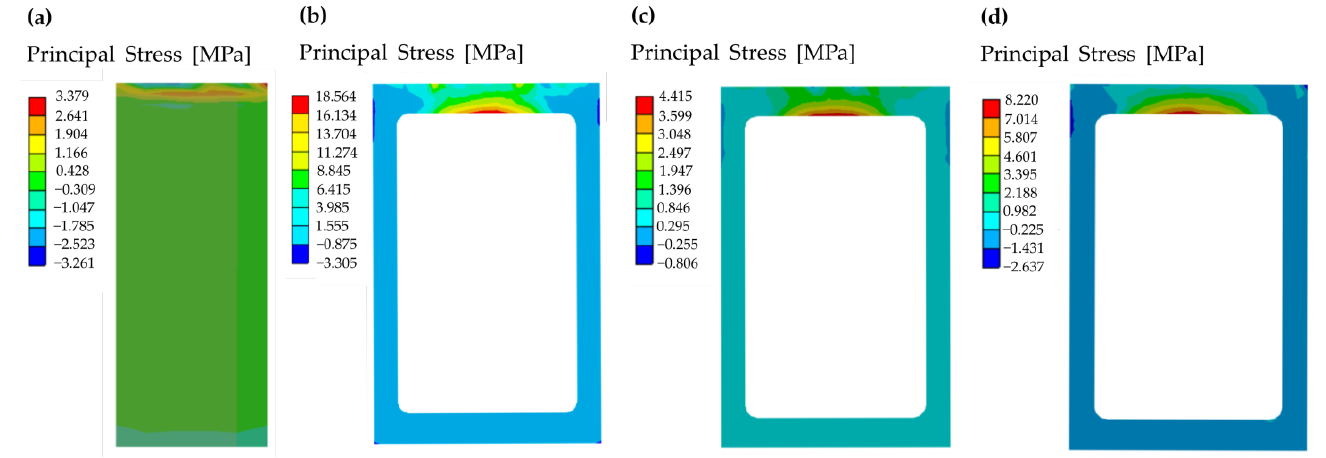
Figure 13. Distribution plot of the principal stresses of the core walls for the ( a ) HR-Liner; ( b ) FHR- Liner type 1; ( c ) FHR-Liner type 2 with 𝑡 𝑠𝑐 = 1 mm and 𝑙 𝑠𝑐𝑃 = 5 mm ; ( d ) FHR-Liner type 2 with 𝑡 𝑠𝑐 = 0.25 mm and 𝑙 𝑠𝑐𝑃 = 5 mm .